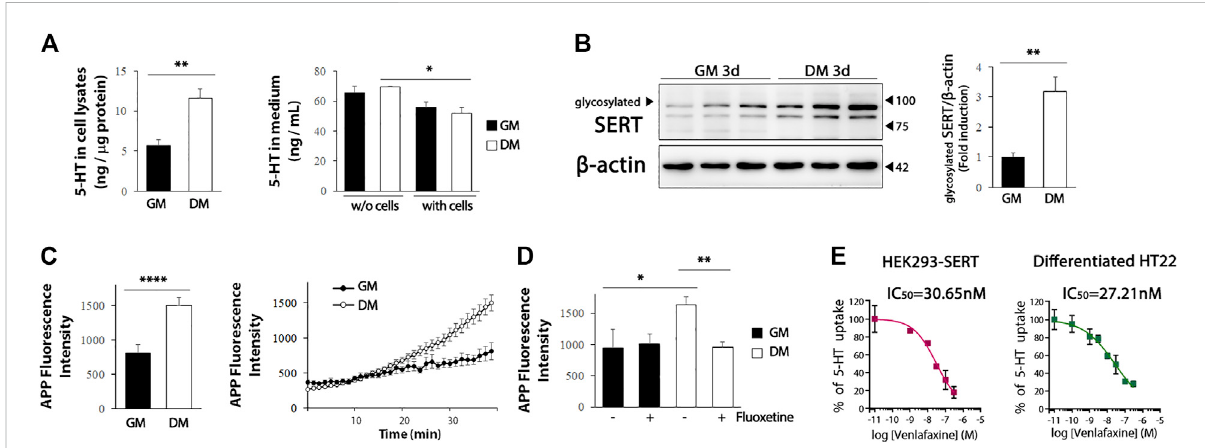
FIGURE 4 SERT activity in differentiated HT22 cells. (A) HT22 cells were grown in normal growth medium and differentiation medium for 3 d, and 5-HT levels were determined in cell lysate (left) and medium (right) using ELISA. (B) Western blotting for glycosylated SERT expression in HT22 cells. Beta- actin was used as loading control. (C) Accumulation of APP + fl uorescence in undifferentiated and differentiated HT22 cells. (D) Co-treatment with fl uoxetine (10 μ M) abolishes accumulation of APP + fl uorescence in differentiated HT22 cells. (E) Venlafaxine (.1 – 1 uM) compete for SERT binding[speci fi cfor ( 3 H)5-HTbinding]inHEK293-SERTanddifferentiated HT22cells. TheIC 50 valuewasgenerated fromeachofthesecurves.Data are representative of at least three independent experiments and are quanti fi ed using densitometric analysis. Statistical signi fi cance: * p < .05, ** p < .01 and **** p <